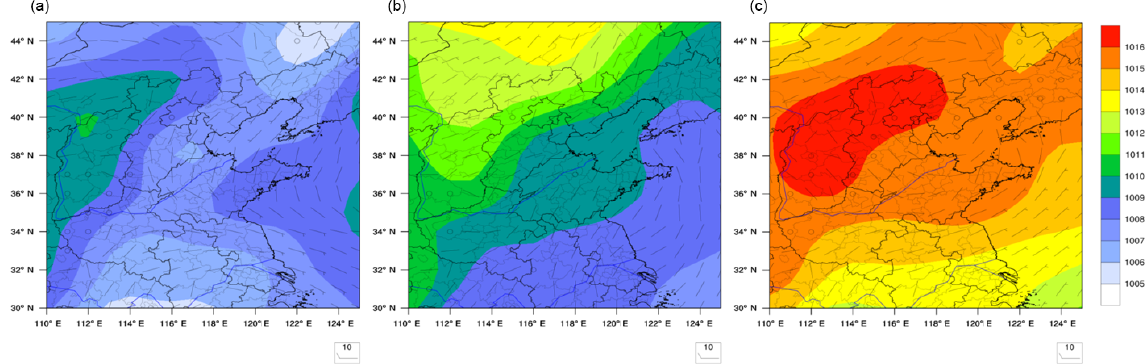
Figure 7. Mean sea level pressure (unit: hPa) and mean wind field at 10m height (unit: ms − 1 ) during the pre-Parade Blue (a) , Parade Blue (b) and post-Parade Blue (c) periods in Beijing and northern China. The colour bar denotes air pressure (unit: hPa) and arrows reflect wind vector (unit: ms − 1 ).